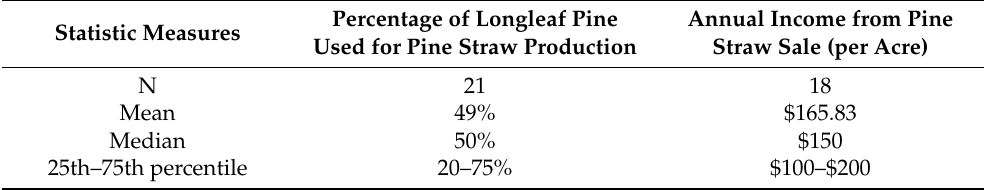
Table 5. Percentage of Georgia’s longleaf pine used for pine straw and average annual